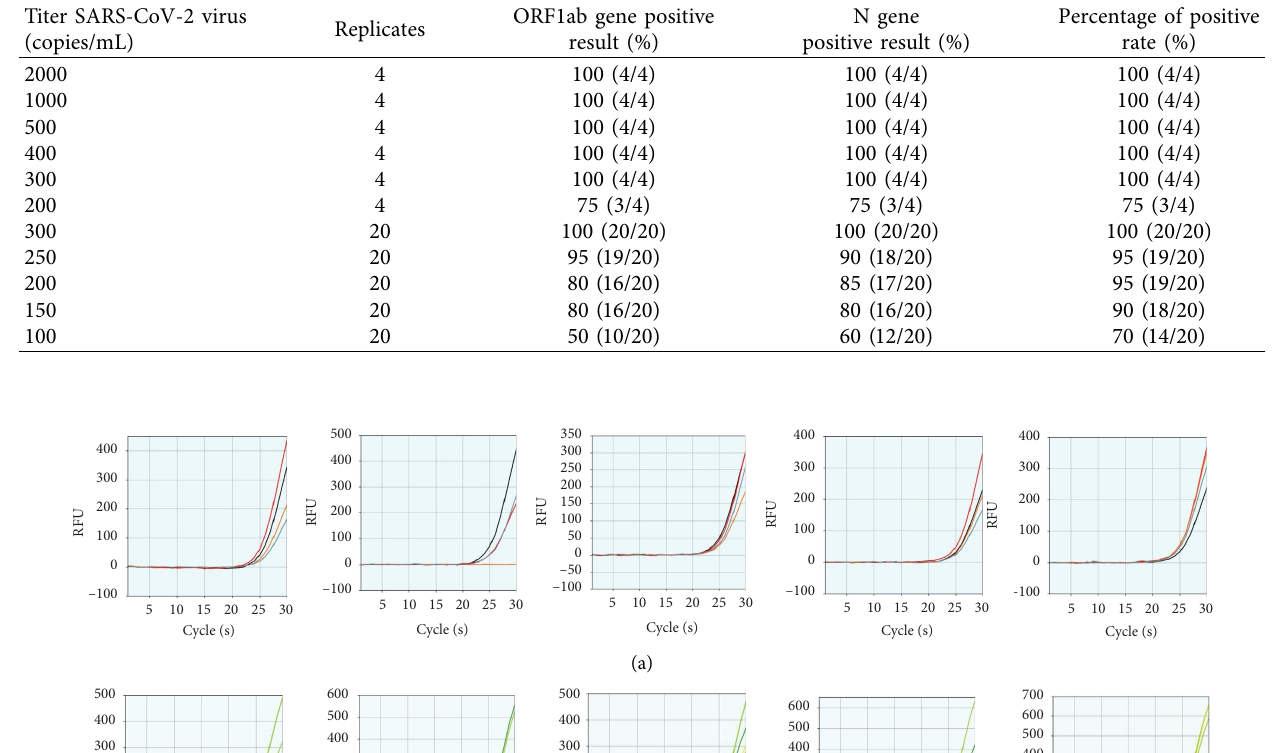
Table 3: LoD determination study results.